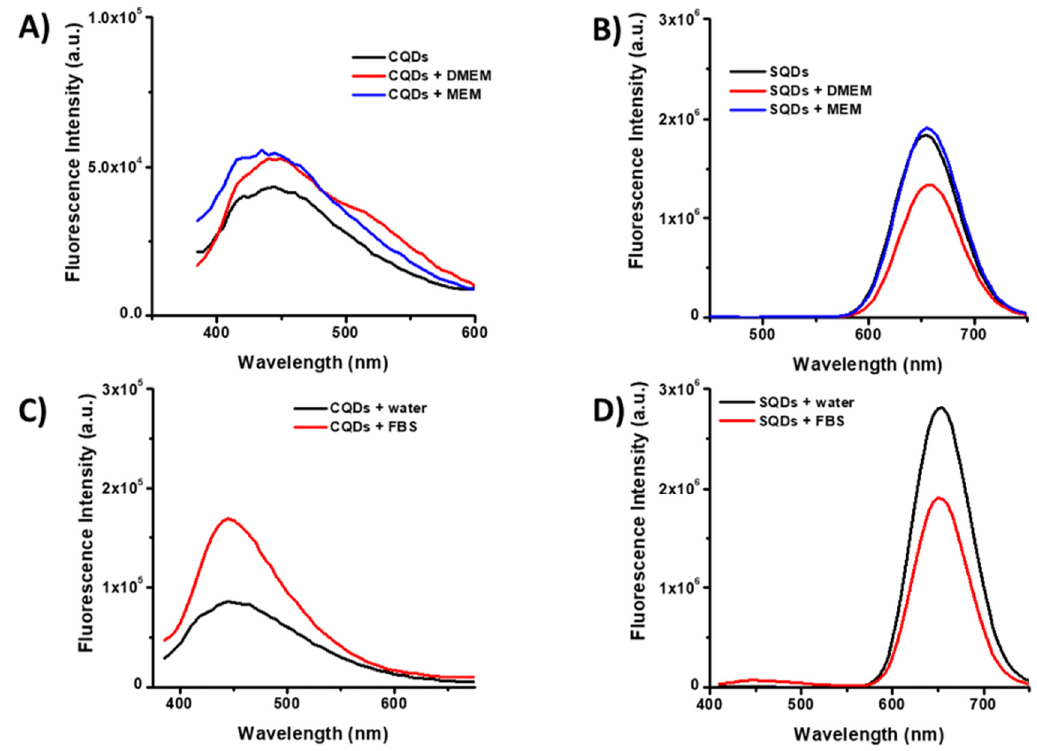
Figure 8. Influence of culture media on fluorescence emission of CQDs and SQDs. Effects of DMEM and Minimum Essential Medium Eagle (MEM) on fluorescence intensity of CQDs ( A ) and SQDs ( B ). Effects of fetal bovine serum (FBS) on fluorescence intensity of CQDs ( C ) and SQDs ( D ). [Nanodots] = 50 mg·L − 1 ; slit widths at emission and excitation were set at 3 nm.